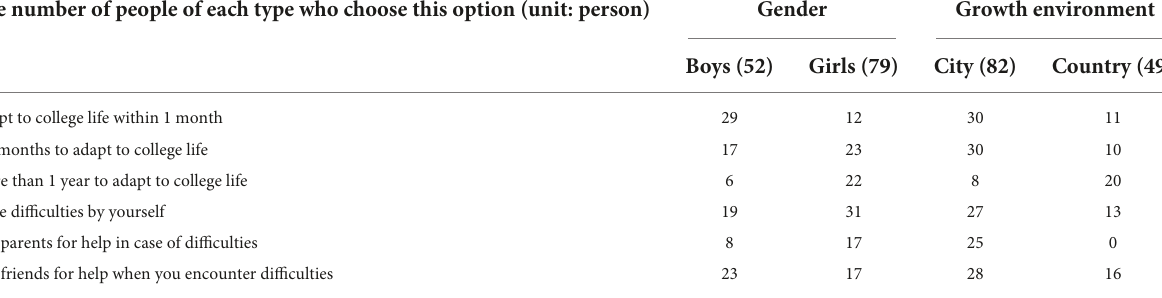
TABLE 12 Intra group comparative data on social psychology of college students from divorced families. The number of people of each type who choose this option (unit: person)